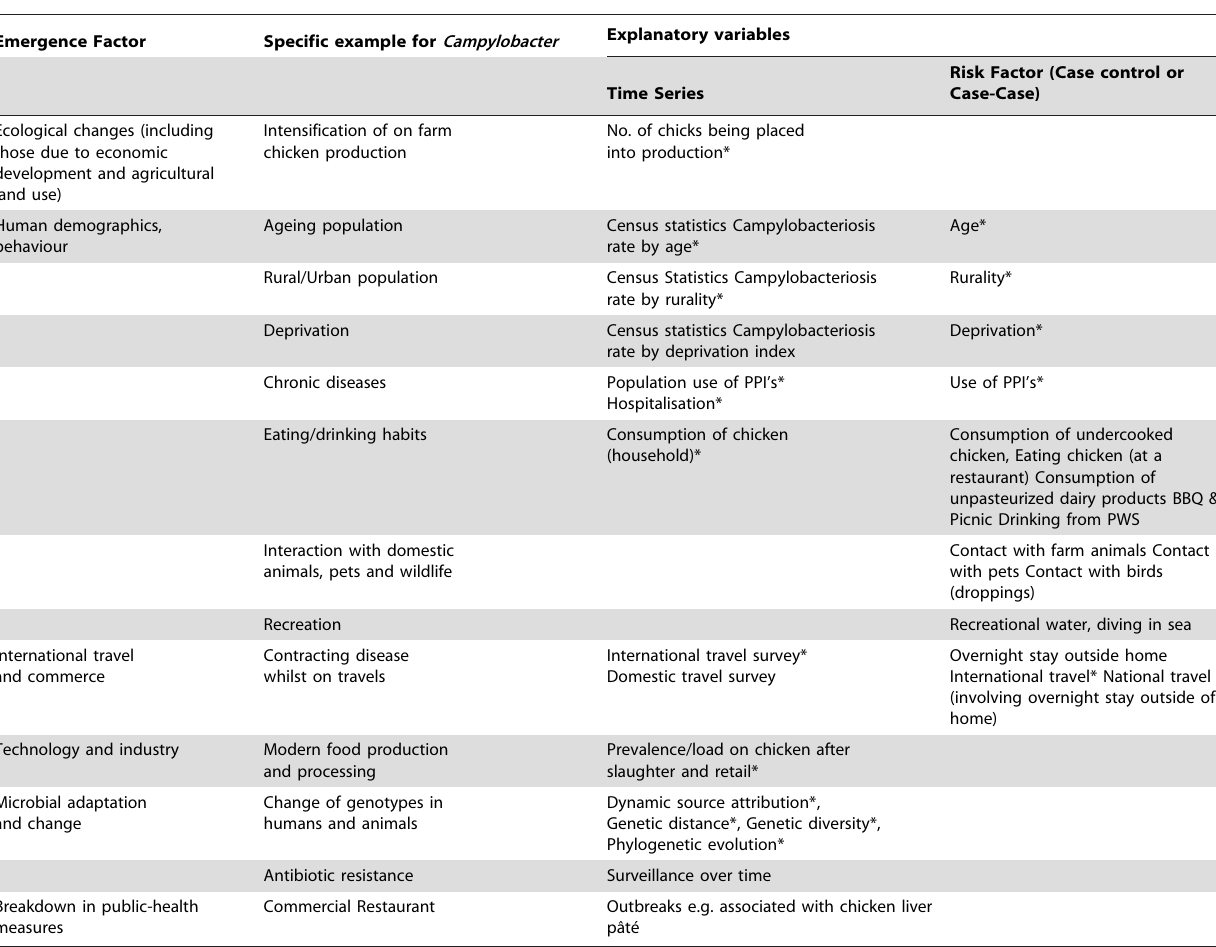
Table 1. Factors and explanatory variables for infectious disease emergence exemplified for human campylobacteriosis.